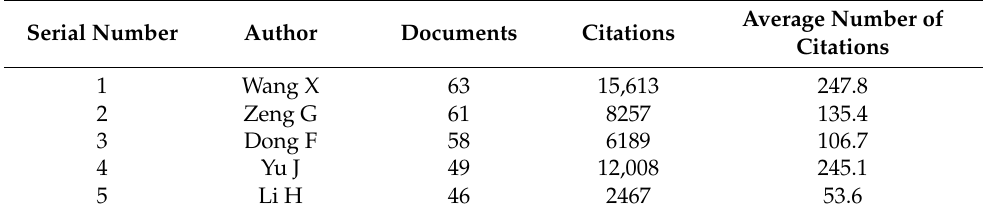
Table 1. Author publications and citations